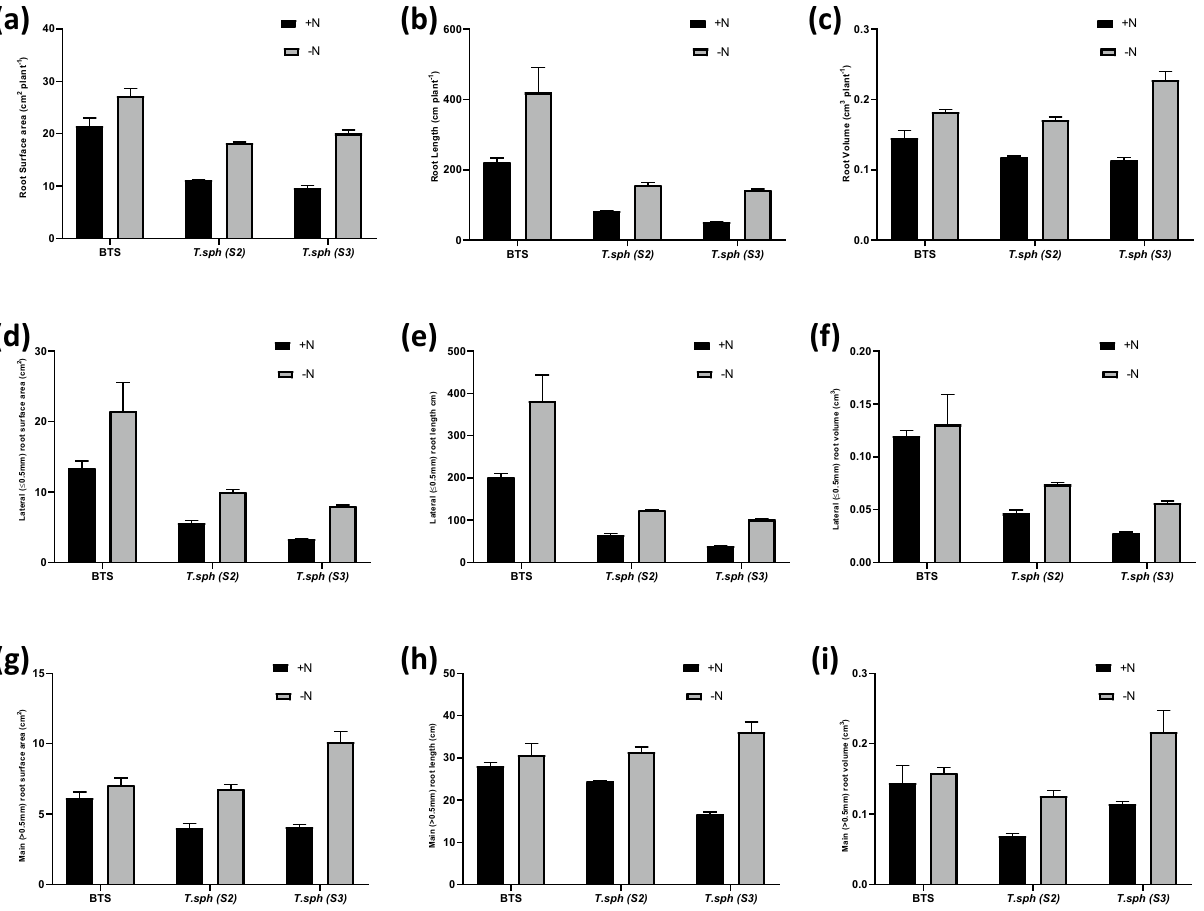
Figure 4. Effect of nitrogen deficient (0.05 mM nitrate, N−) and nitrogen sufficient (7.5 mM nitrate, N+) conditions on surface area ( a , d , g ), root length ( b , e , h ) and root volume ( c , f , i ) of total, lateral and main roots of thirty days old seedlings of wheat genotypes grown under hydroponic